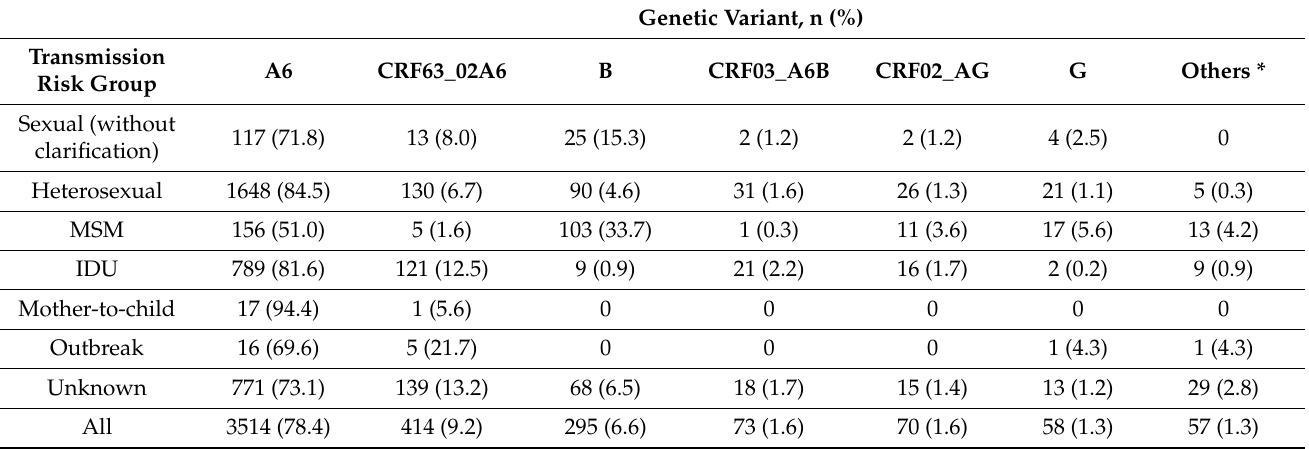
Table 2. Prevalence of HIV-1 genetic variants among the transmission risk groups.